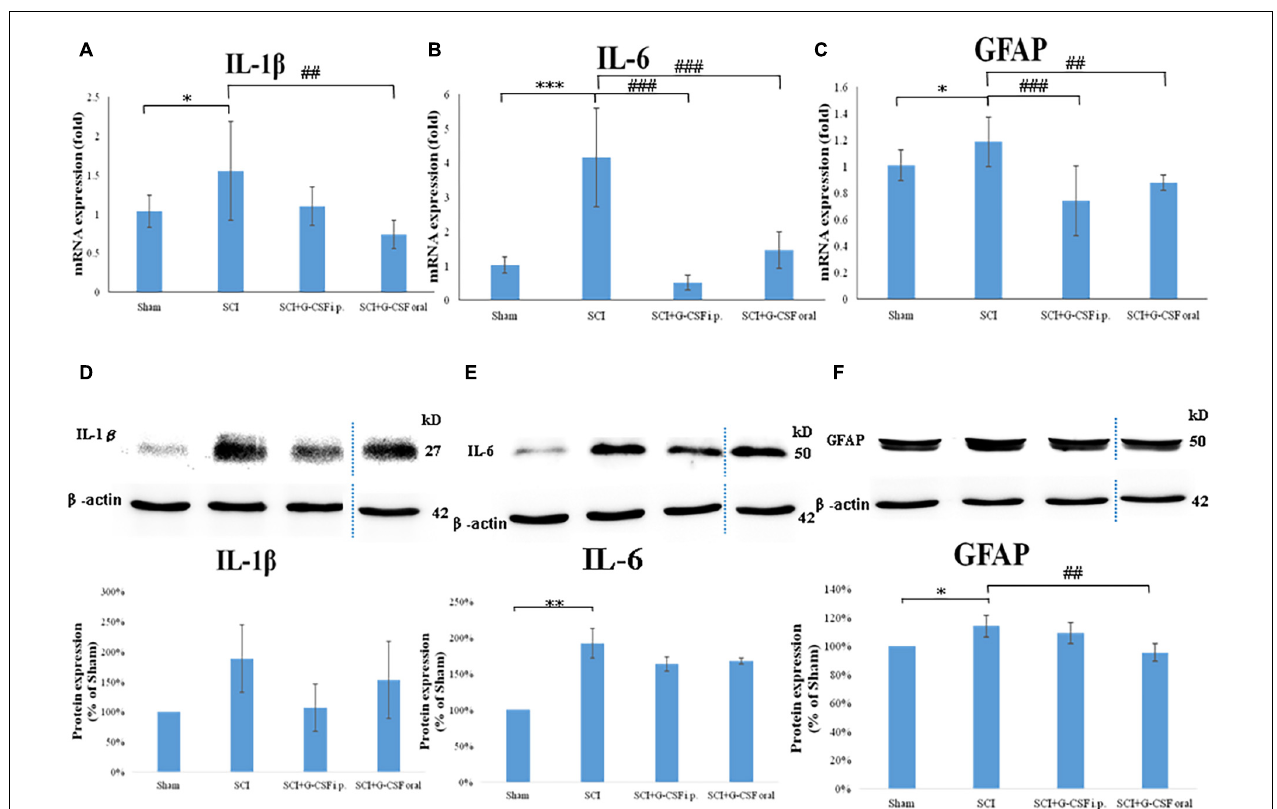
FIGURE 3 | Neuroinflammation in the mouse olfactory bulb at 8 h post-spinal cord injury (SCI). (A–C) The mRNA expression levels of IL-1 β (A) , IL-6 (B) , and GFAP (C) in the olfactory bulb of the sham control, SCI, SCI + granulocyte colony-stimulating factor (G-CSF) i.p., and SCI + G-CSF oral groups at 8 h post-SCI. Vertical bars indicate the mean ± standard error of the mean (SEM) ( n = 6 for each group). ∗ P < 0.05, ∗∗∗ P < 0.001, ## P < 0.01, and ### P < 0.001. (D–F) The protein expression levels of IL-1 β (D) , IL-6 (E) , and GFAP (F) in the olfactory bulb of the four experimental groups at 8 h post-SCI. Representative immunoblots of IL-1 β , IL-6, GFAP, and β -actin (internal control) are shown in the upper panel. The lower panel indicates the ratio of target protein band intensity to β -actin protein band intensity relative to the control group (mean ± SEM). G-CSF mitigates SCI-induced neuroinflammation in the olfactory bulb as evidenced by the decreased expression of IL-1 β , IL-6, and GFAP. Vertical bars indicate mean ± SEM ( n = 6 for each group). ∗ P < 0.05, ∗∗ P < 0.01, and ## P <